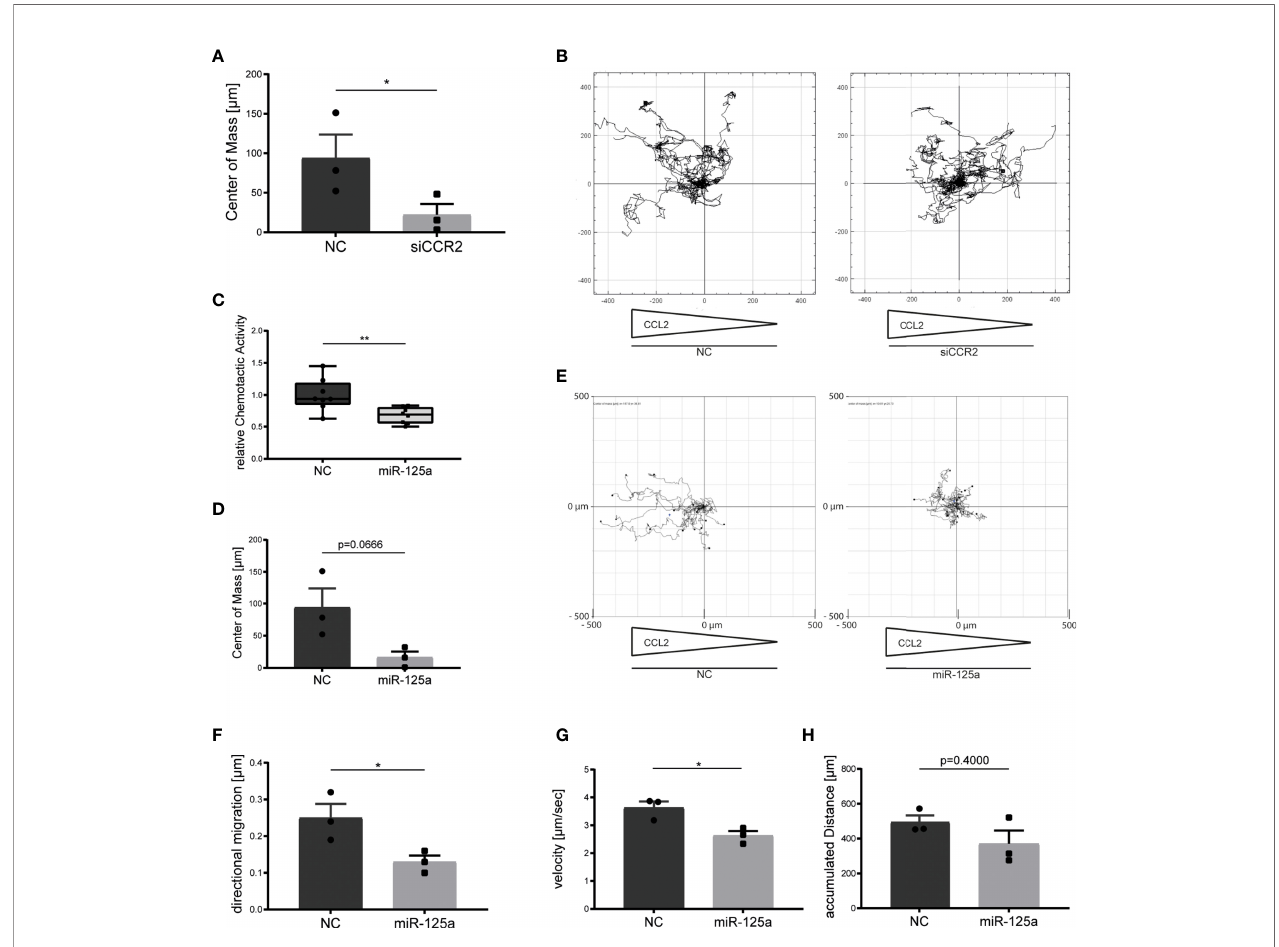
FIGURE 6 | Effect of miR-125a on monocyte chemotaxis. CCL2-speci fi c monocyte chemotaxis after transfection of siRNA speci fi cally targeting CCR2 (A, B) , miR-125a (C – H) or the respective scrambled controls (NC). Monocyte migration was recorded by time-lapse microscopy and subsequently analyzed by single-cell tracking analyses. (n=3, *p<0.05, **p<0.01). (A) Center of mass representing the average of all single cell endpoints. (B) Exemplary chemotaxis plot of three independent experiments. Arrows below the plot indicate the CCL2 concentration gradient. (C, D, F – H) miR-125a impacts chemotactic activity, center of mass, directional migration and velocity without affecting the accumulated distance. (E) Exemplary chemotaxis plot of three independent experiments. Arrows below the plot indicate the CCL2 concentration